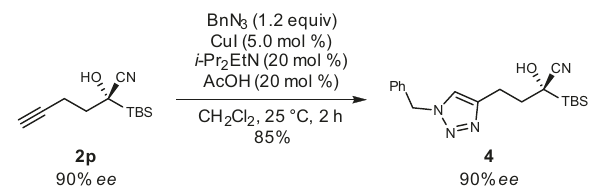
Fig. 7 CuAAC of 2p. The alkynyl group of 2p was amenable to click ligation.